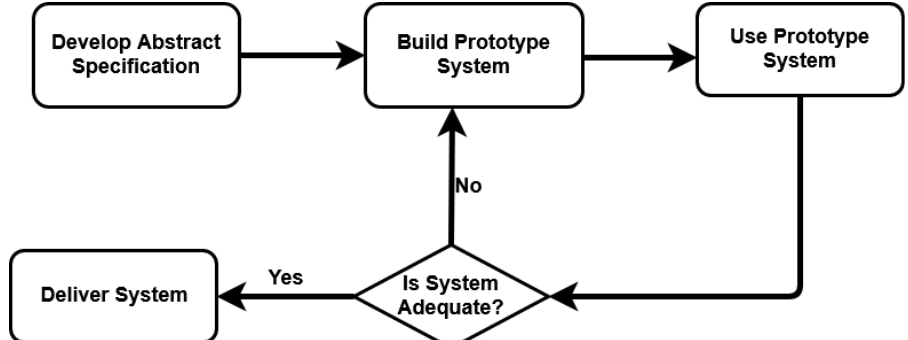
Figure 3. EFDMS database schema